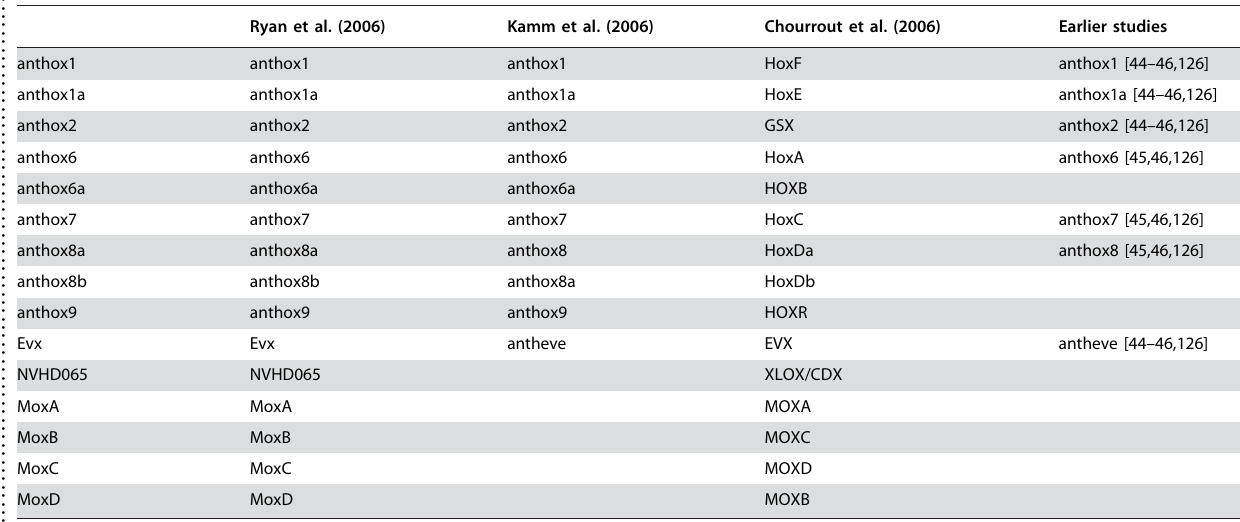
Table 1. Nomenclature of Nematostella Hox and Hox-related genes. .. ... .... ... ... .... ... ... .... ... ... .... ... ... .... ... ... .... ... ... .... ... ... .... ... ... .... ... ... .... ... ... .... ... ... .... ... ... .... ... ... .... ... ... . Ryan et al.